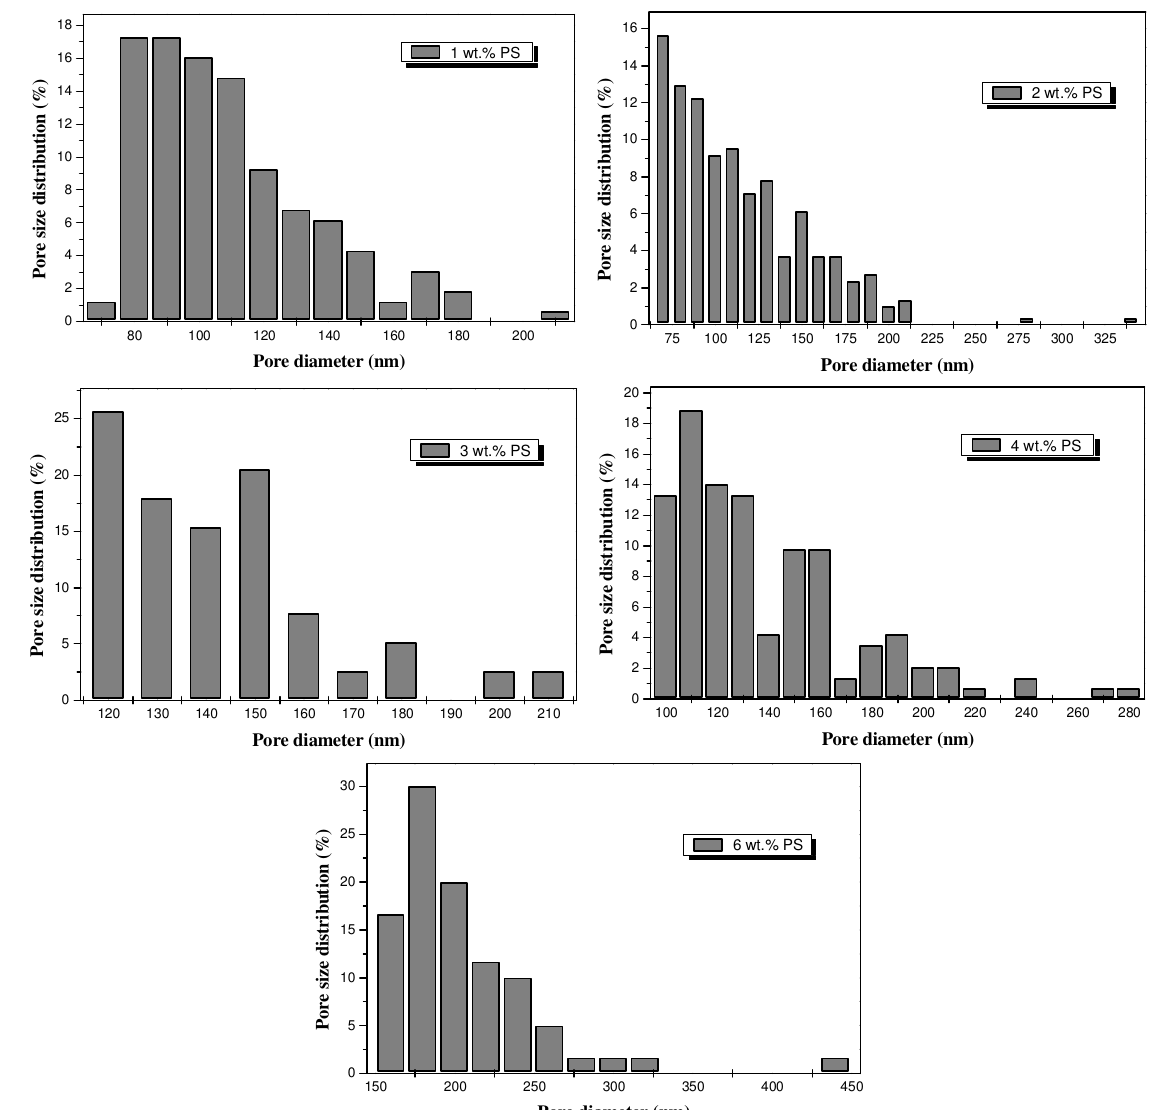
Fig. 5. Pore size distributions of the inner surface of the hollow fiber blend